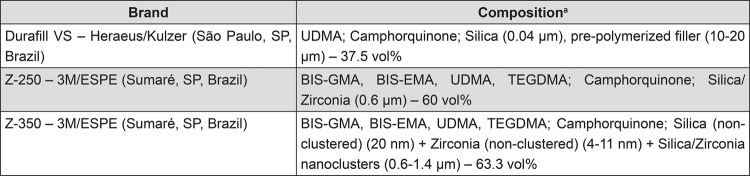
Composition of the assessed composite resins